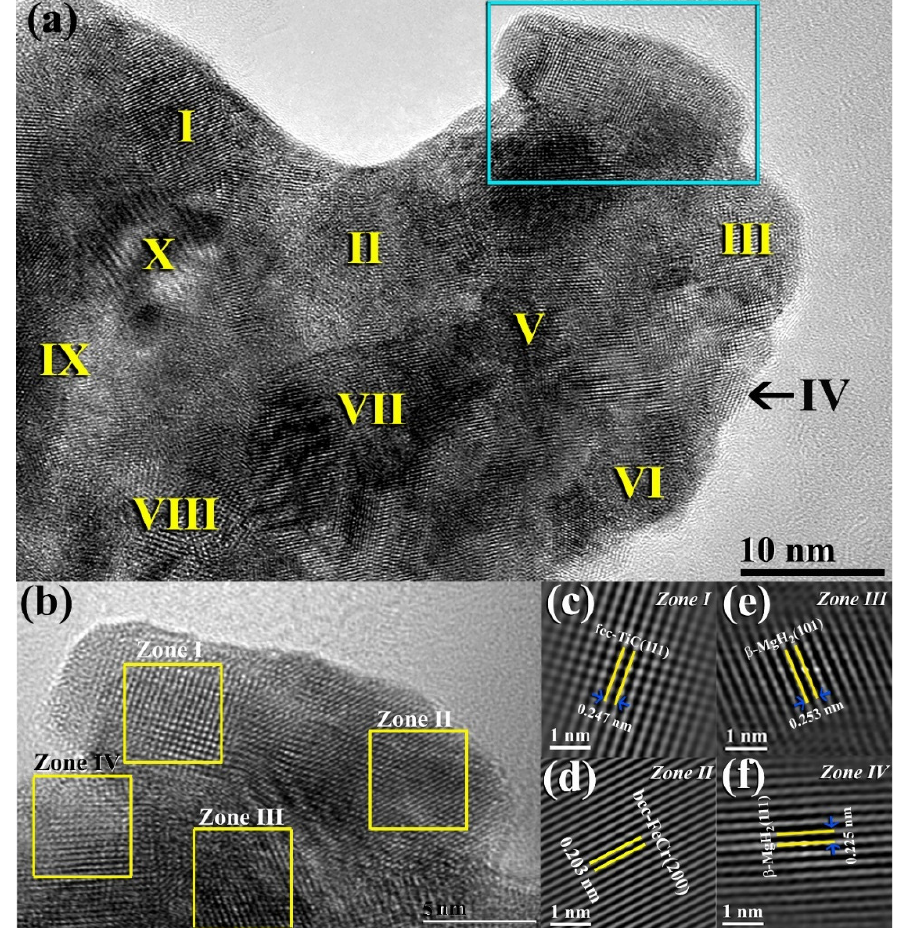
Figure 2. ( a ) BFI micrograph of as-milled MgH 2 /5.2TiC/4.6FeCr nanocomposite powders obtained after 50 h of ball milling time. The Roman Numerals presented in ( a ) refer to the points used for EDS local analysis (Table 1). The atomic-resolution TEM image of the squared zone indexed shown in ( a ) is presented in ( b ). The FFT lattice images for zones I, II, III, and IV, shown in Figure 2b are displayed in ( c – f ),